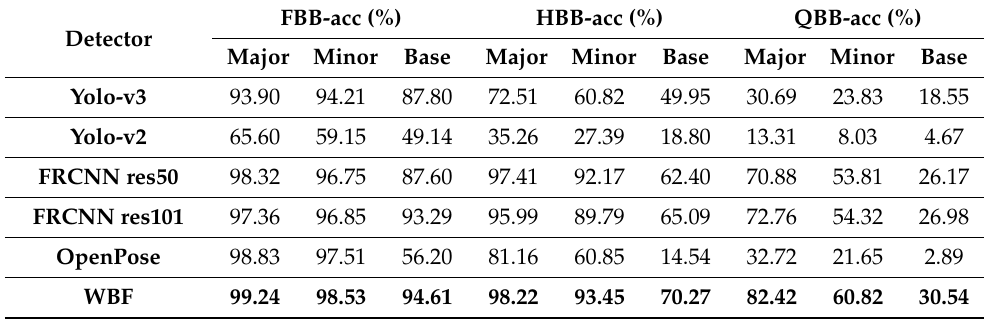
Table 7. Cross-dataset evaluation of 11k dataset with model M